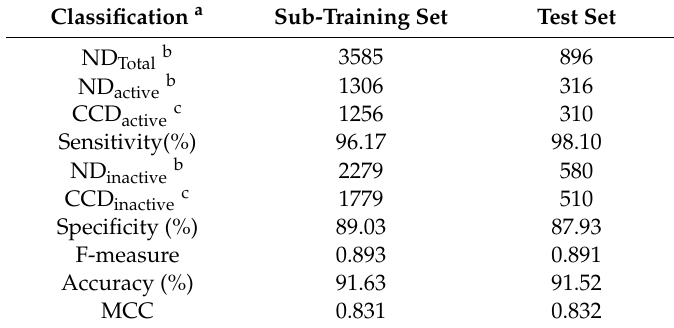
Table 1. Overall performance of the final multitarget quantitative structure–activity relationship (mt-QSTR) linear discriminant analysis (LDA)